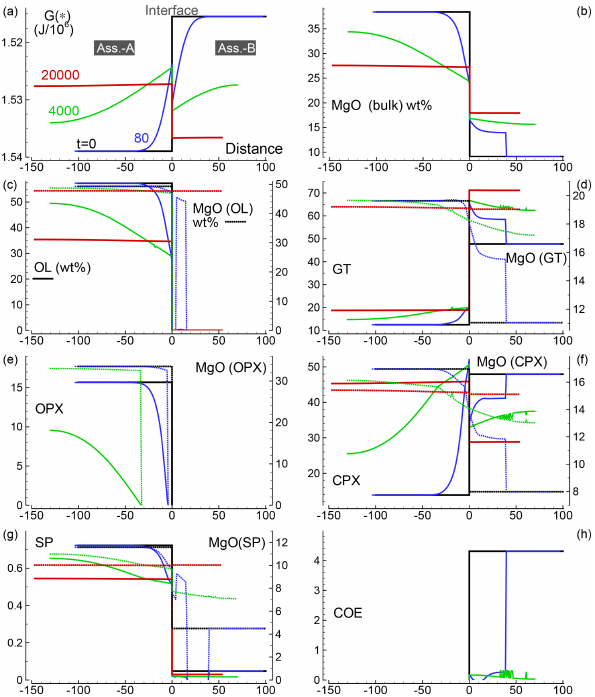
Figure 3. Solution of a 1-D model simulation. The initial propor- tion of the two assemblages is 5 : 1 ( f = 5). The description of the panels follows the caption provided for Fig.